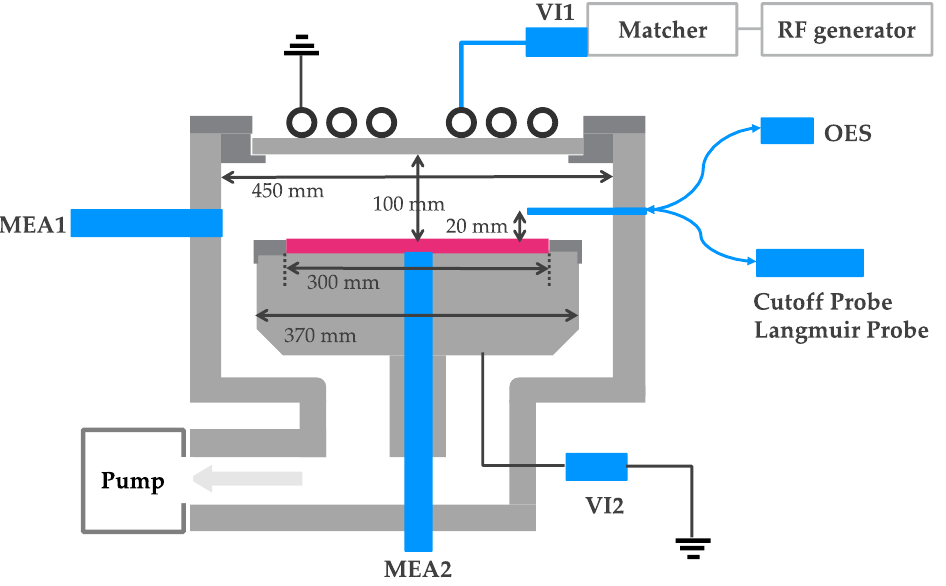
Figure 1. Schematic of the experimental device. VI probe (VI1, VI2), mass/energy analyzer (MEA1, MEA2), optical emission spectroscopy (OES), self-plasma OES (SP-OES), cutoff probe (CP), and Langmuir probe (LP).